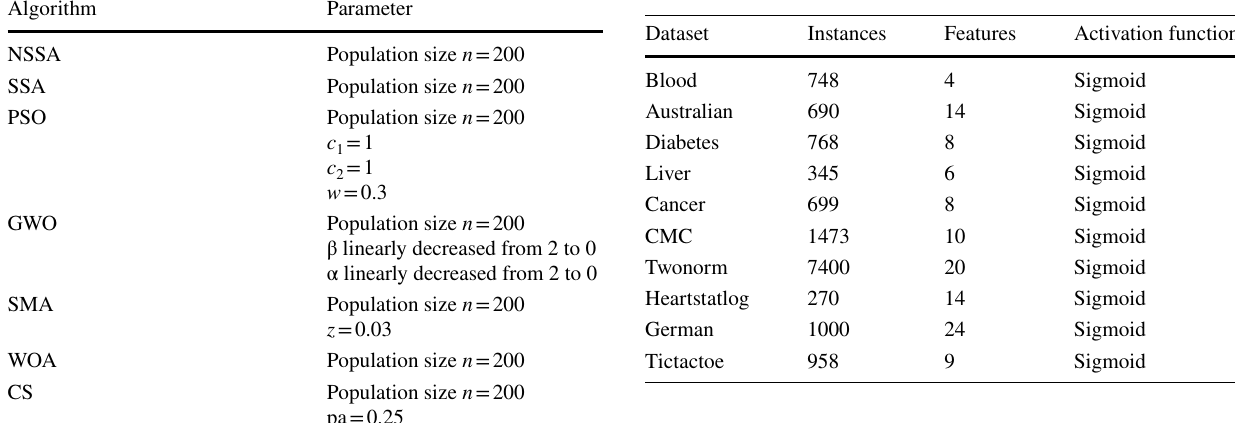
Table 2 Classification